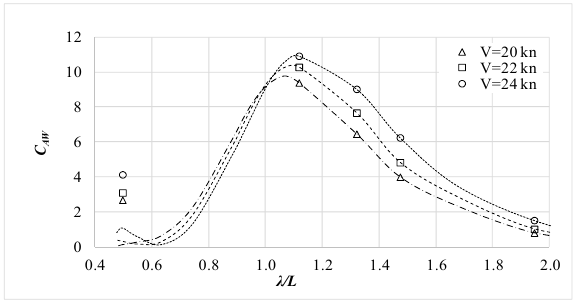
Figure 8. Influence of pitch gyration radius on added resistance coefficient in irregular waves: r yy / L PP = 0.24 ( left ), r yy / L PP = 0.26 ( right ).